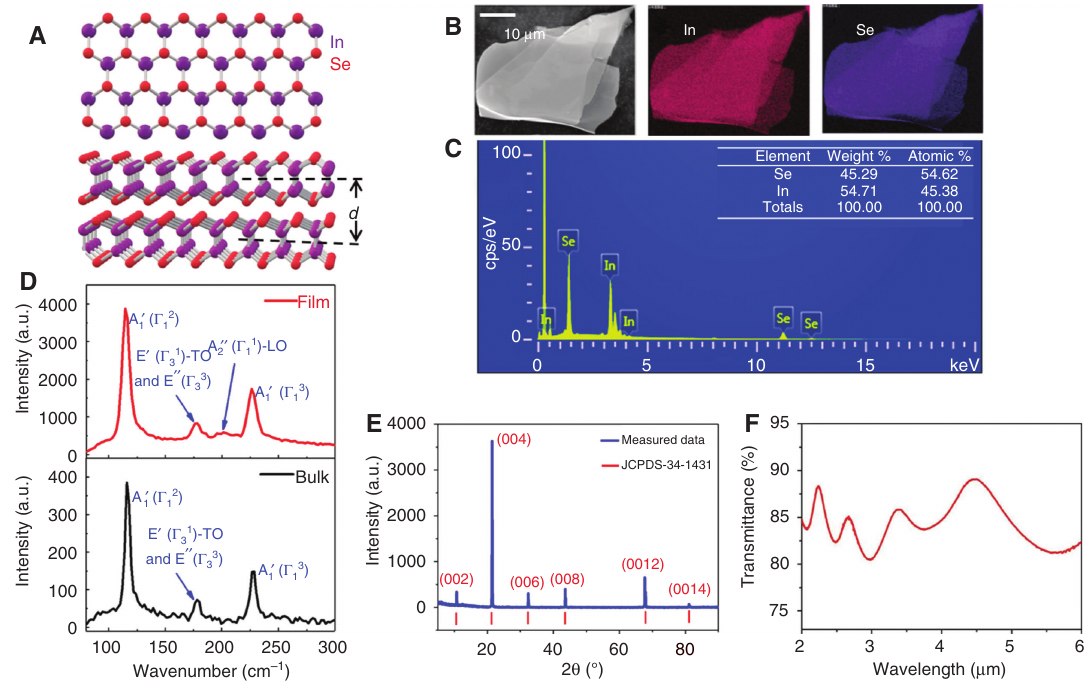
Figure 1: Characterization and optical properties of InSe film. (A) Structures of InSe at top and side views; d , layer distance: 0.83 nm. (B) Scanning electron microscopy mapping of InSe film. (C) Energy- dispersive X-ray spectroscopy image and the corresponding element content of InSe film. (D) Raman spectra of the prepared InSe film and bulk InSe. (E) X-ray diffraction spectrum of the prepared InSe film. (F) Absorption spectrum of the prepared InSe film.